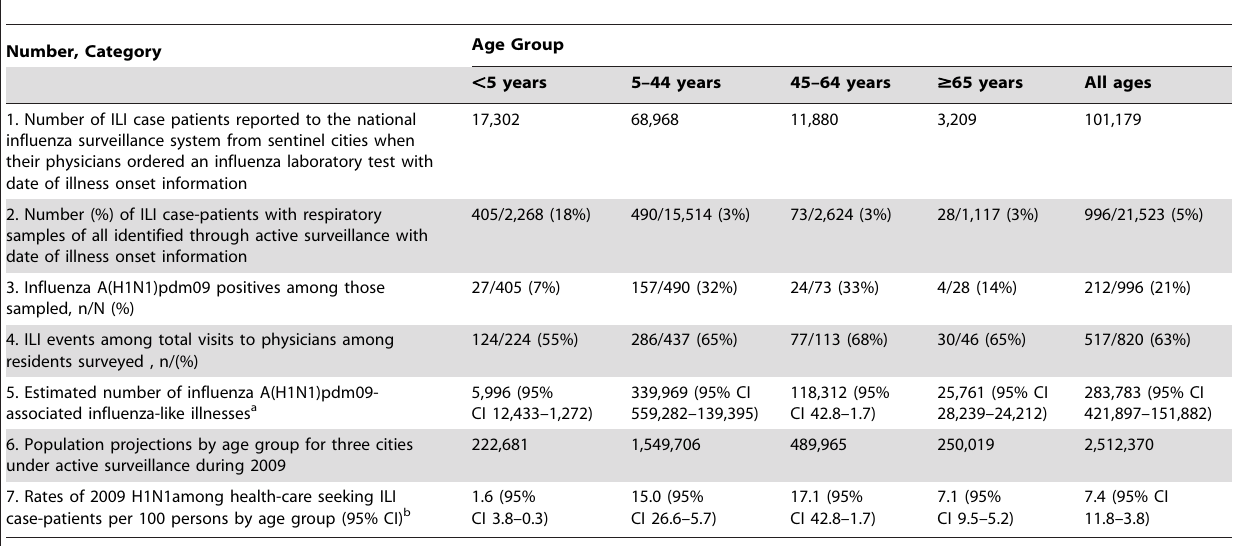
Table 3. Rates of influenza A(H1N1)pdm09-associated influenza-like illness case-patients at three sentinel cities in Argentina, according to age group April–December,